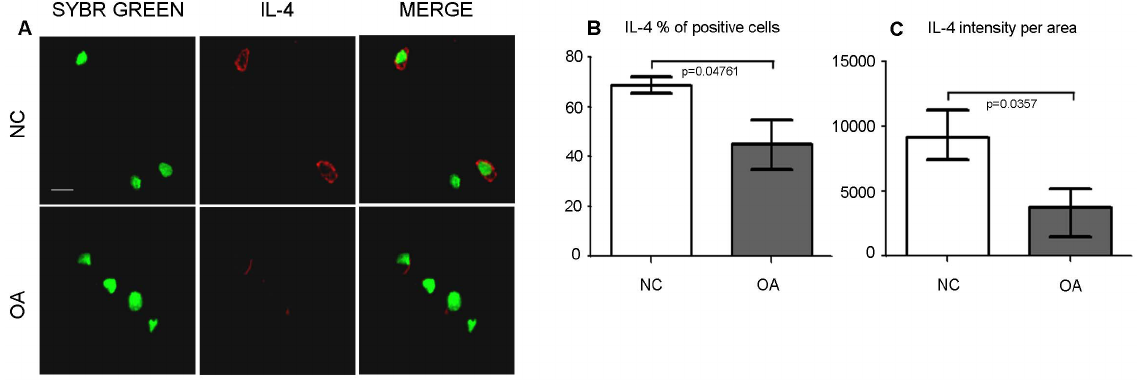
Figure 1. Analysis of IL-4 expression in normal and osteoarthritic cartilage. A : representative examples of IL-4 staining in controls (NC), and OA cartilage as detected by confocal microscopy. Panels show IL-4 staining (Dy Light 647, rendered in red), nuclear counterstaining (sybr green, rendered in green) and merged signals (bar =10 m m). B : percentage of IL-4 positive cells in mid-deep layers of control (NC, n=3), and OA cartilage (n=6). Bars and whiskers indicate mean and S.E.M., respectively. Data were compared with unpaired data analysis using the Mann-Whitney U test (p=0.0476). C : level of IL-4 expression (shown as mean intensity per positive cell area) in controls (NC), and OA cartilage following confocal analysis. Comparison was performed by the Mann-Whitney U test